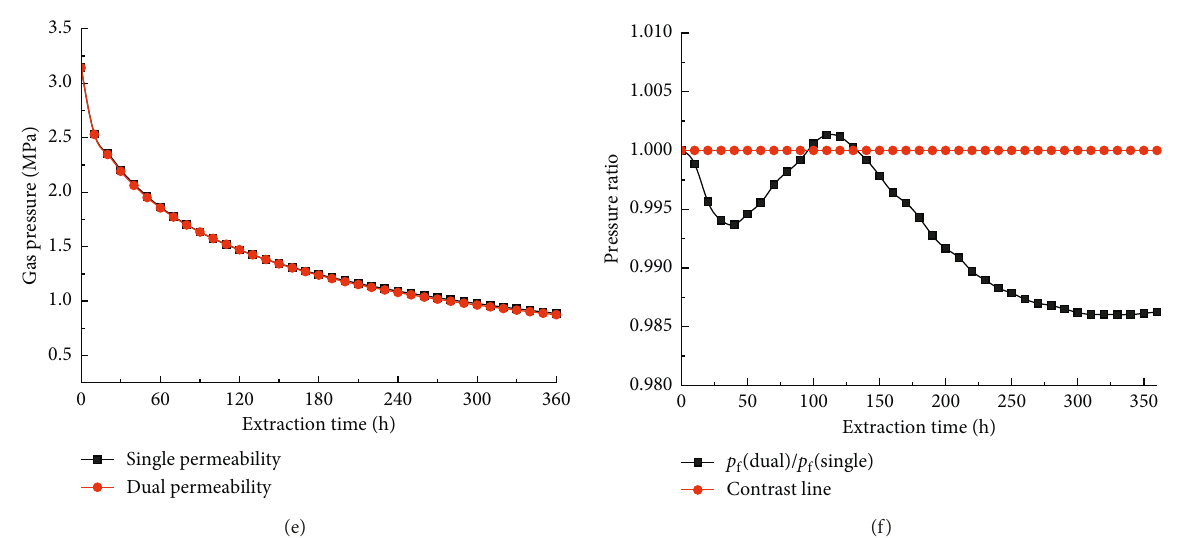
Figure 12: Comparative analysis of gas pressure in two models at different locations. Gas pressure and pressure ratio at (a) Point A, (b) Point B, and (c) Point